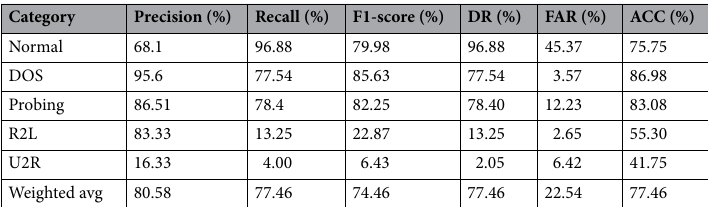
Table S1 online. The final coefficient parameter of 192 rules with four attributes (number of attribute’s intervals greater than 1) can be found as Supplementary Table S2 online.